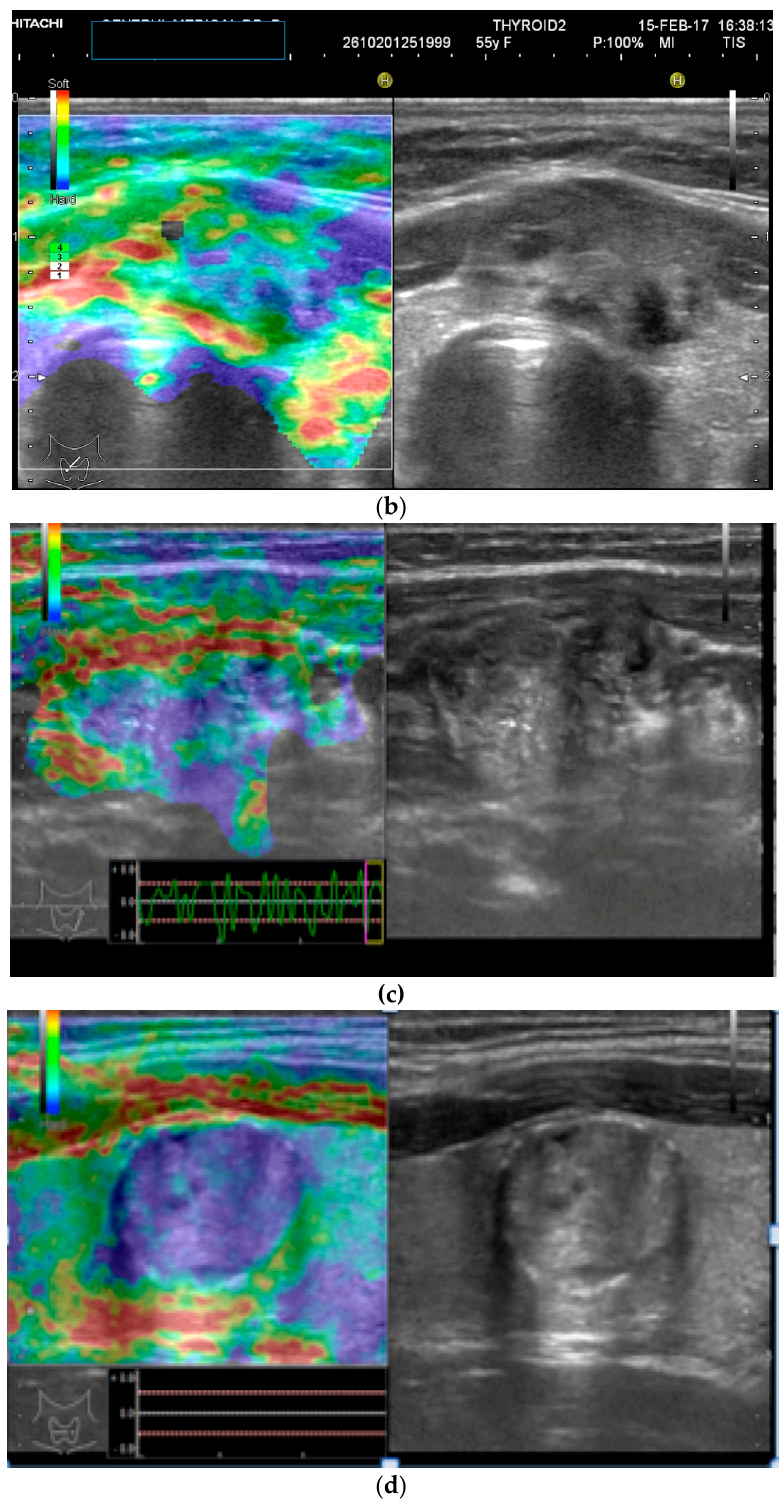
Figure 1. ( a ) Follicular neoplasia with no endothelial invasion, US low risk; ( b ) Noninvasive follicular neoplasia, intermediate US risk; ( c ) Hurthle cell carcinoma—high US risk; ( d ) Follicular adenoma—high US